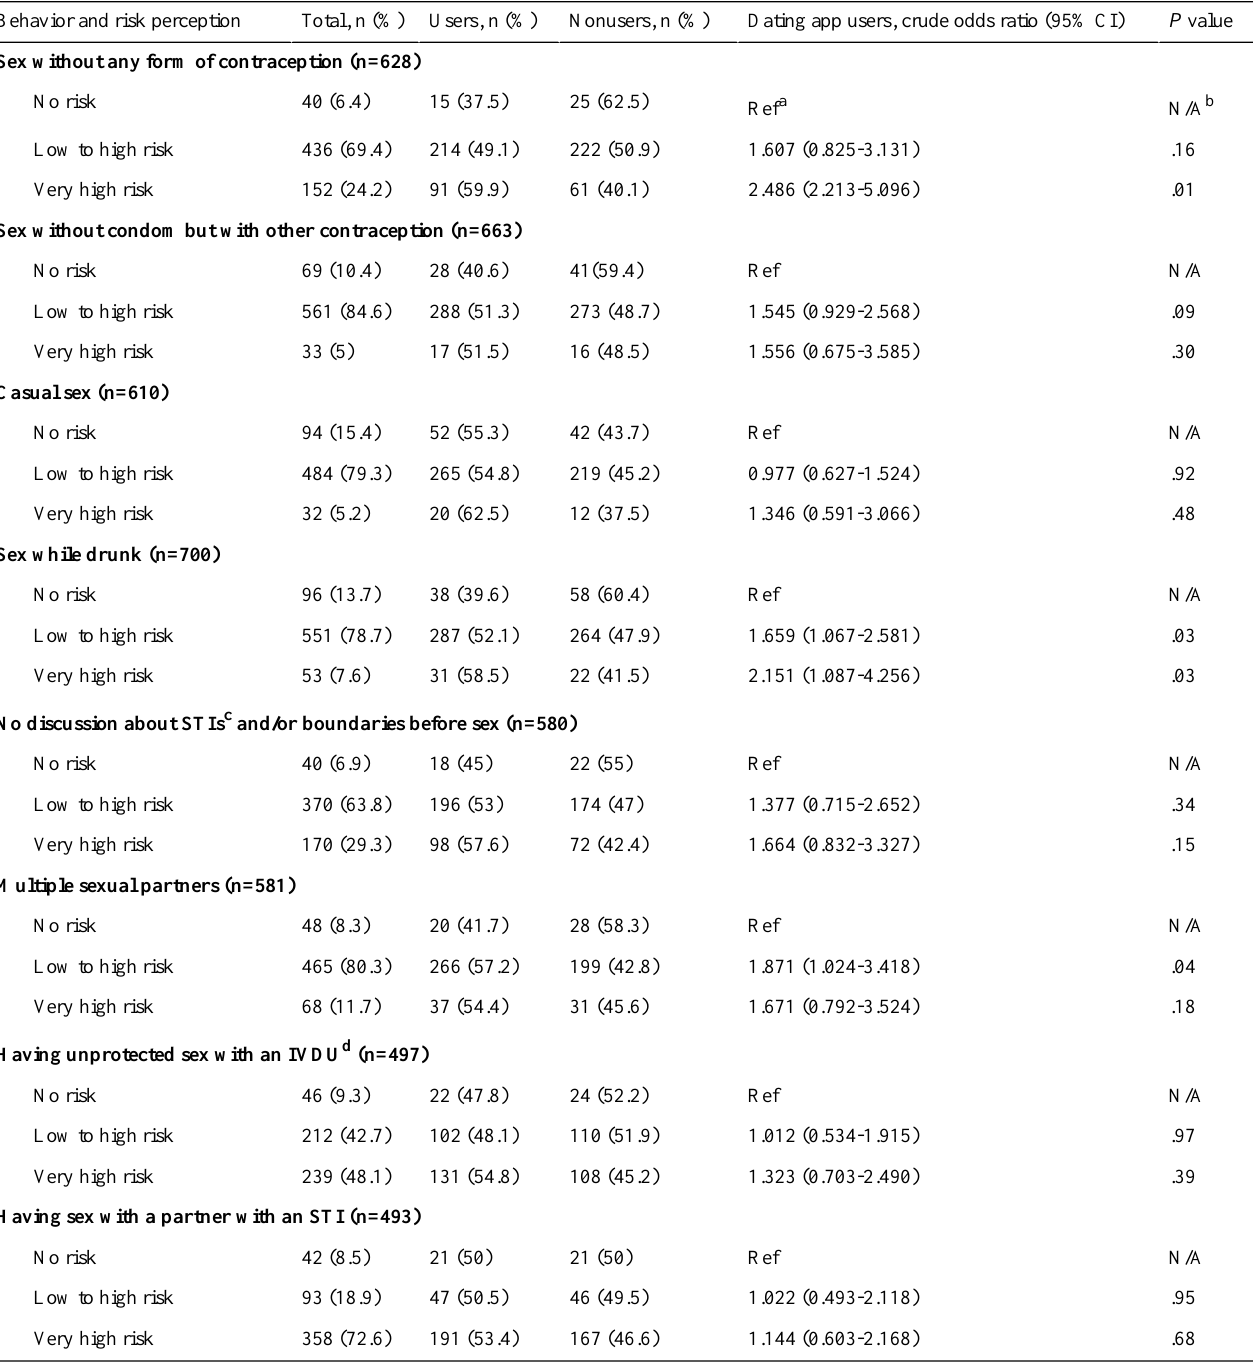
P valueDating app users, crude odds ratio (95% CI)Nonusers, n (%)Users, n (%)Total, n (%)Behavior and risk perception